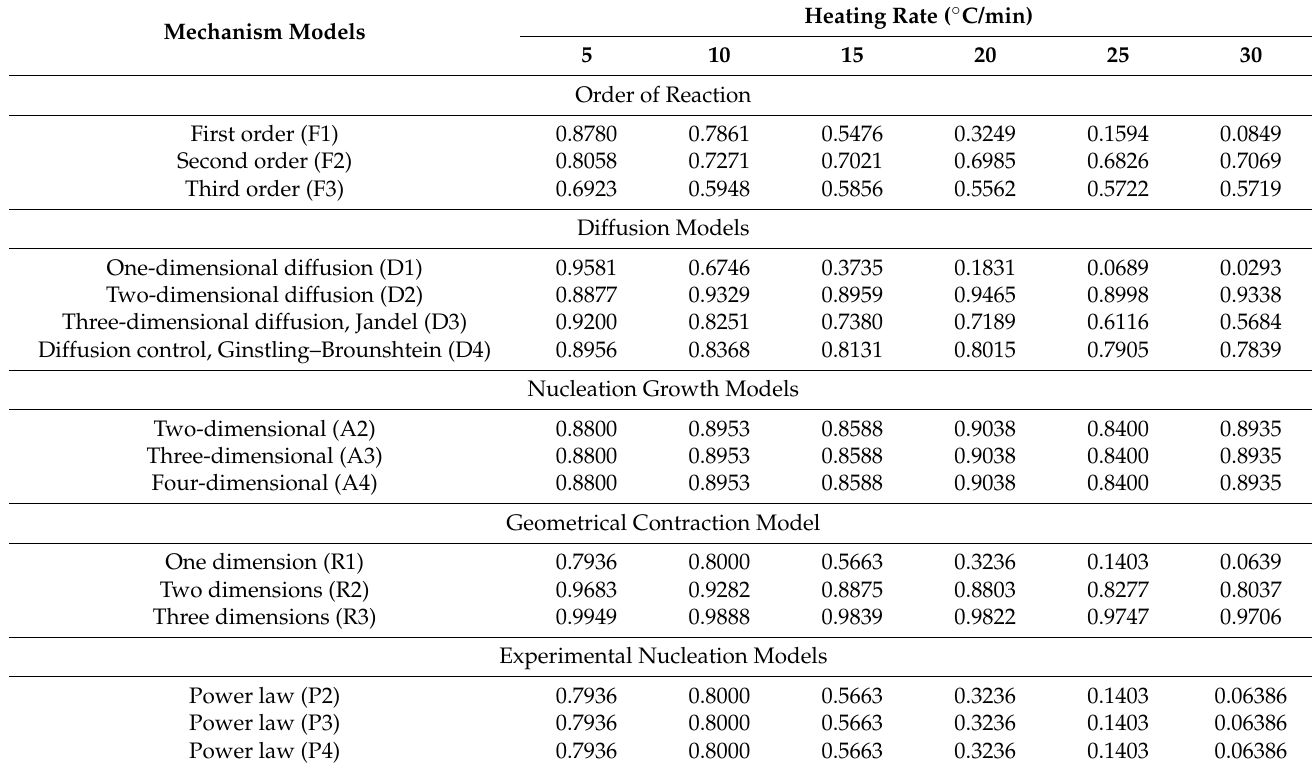
Table 5. Determination coefficient R 2 calculated from kinetic parameters for different models with α values obtained from TGA-simulated curves by the Coats–Redfern equation.